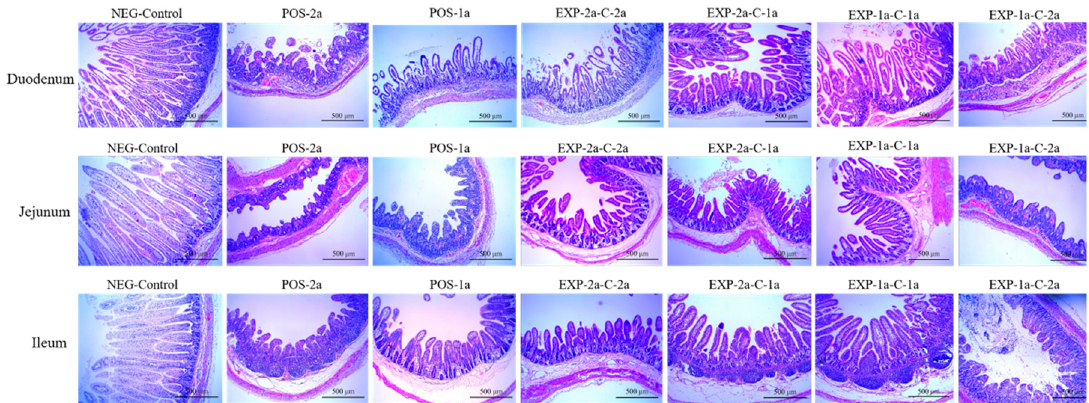
Figure 4. Hemotoxylin and eosin-stained tissue sections of small intestine in piglets challenged by PEDV strains CV777 and/or CH/JX/01 (×100).